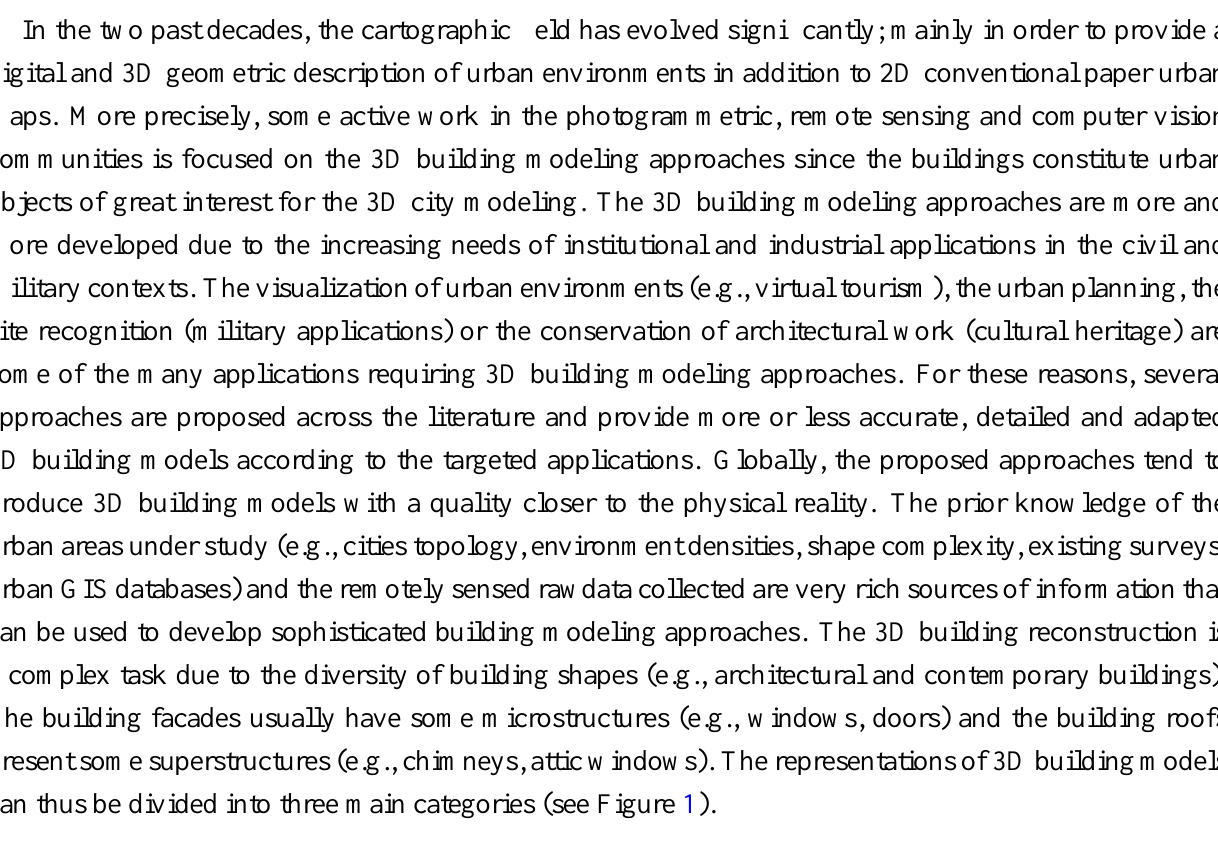
Figure 1. Examples of generic model representations. Three illustrations of the same building with different level of details (from low to high).